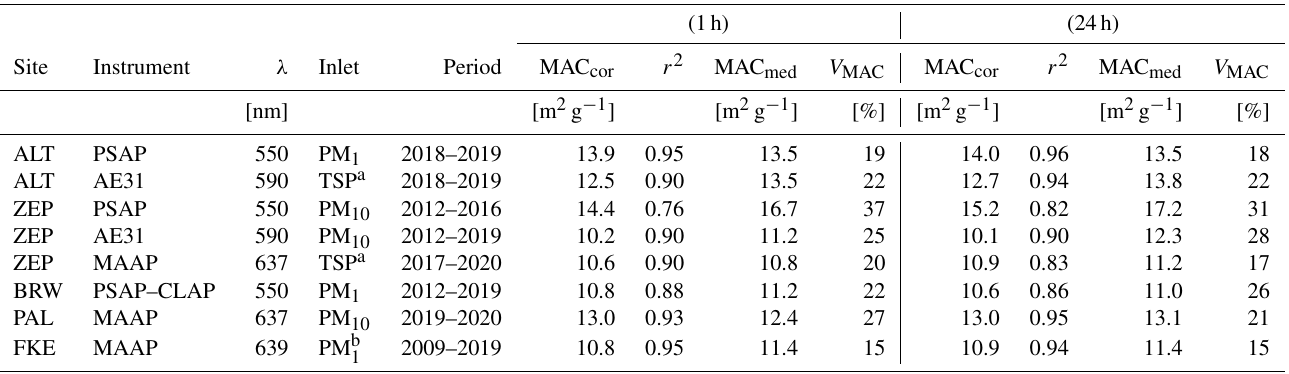
Table 3. MAC, r 2 , and variability of MAC ( V MAC ; interquartile range in relative terms) of MAAP, PSAP–CLAP, and Aethalometer at observation sites in this study.